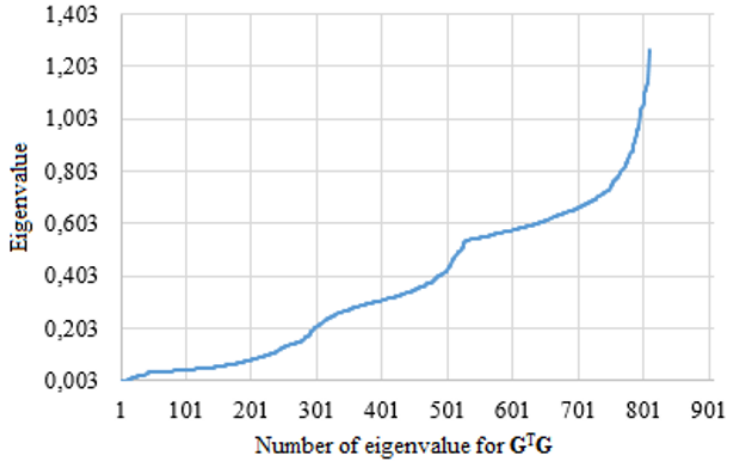
Fig. 5. Dependency of G T G eigenvalues to their